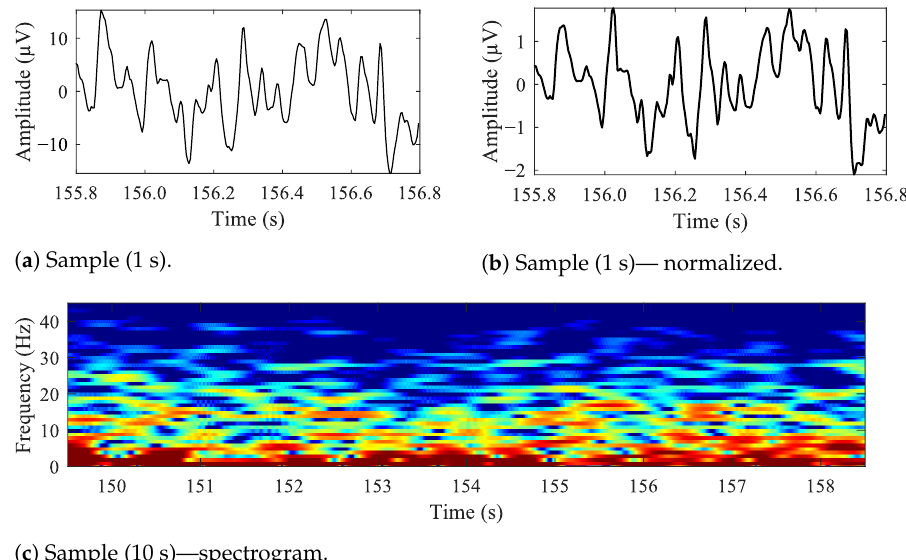
Figure 5. Sample EEG data recorded from ‘F3–C3’